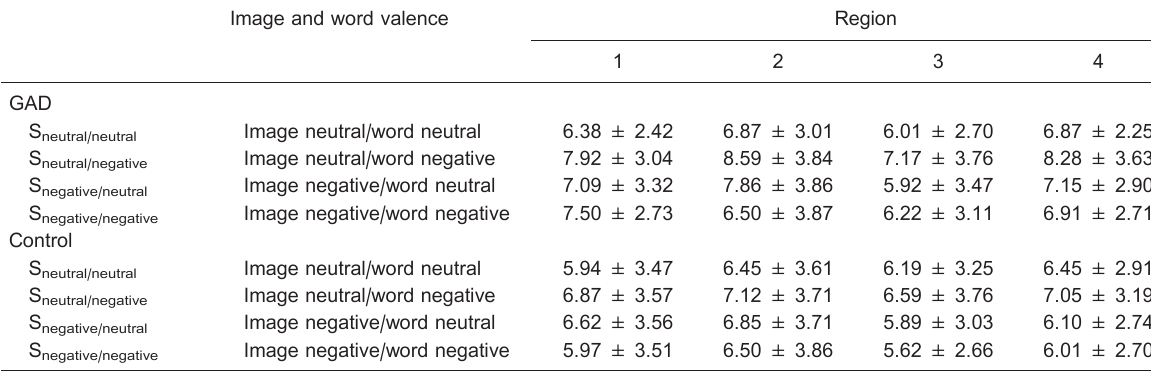
Table 3. Mean amplitudes for P300 in four brain regions under four conditions ( m